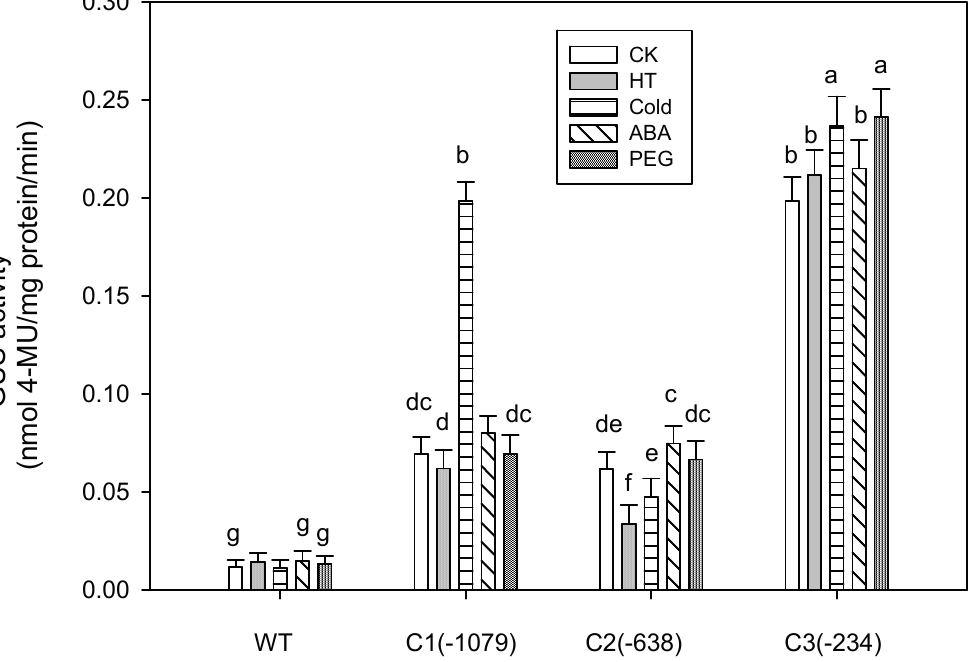
Figure 5. Abiotic stress-induced GUS activity analysis of transgenic Arabidopsis lines. Six-week-old Arabidopsis T3 plants and wild type (WT) were subjected to ABA, high temperature (HT), cold (4 °C), and drought (20% PEG6000) treatments for 6 h. Control (CK) plants were treated with water. GUS activity was analyzed fluorometrically and expressed as nmoles 4-methylumbelliferone (MU)/mg protein/min. Data are expressed as the mean ± standard deviation of three independent assays involving Arabidopsis leaf extracts. The same letters indicate no significant differences at p ≤ 0.05 by Duncan’s